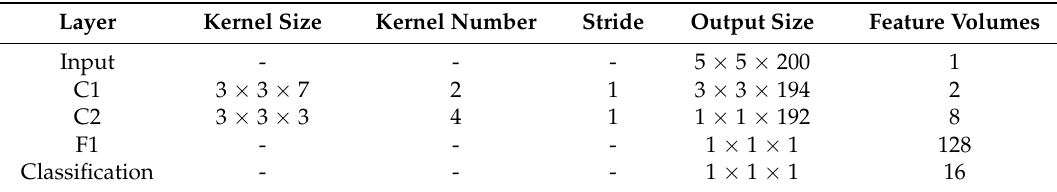
Table 8. Architecture of 3D-CNN in Indian Pines scene.